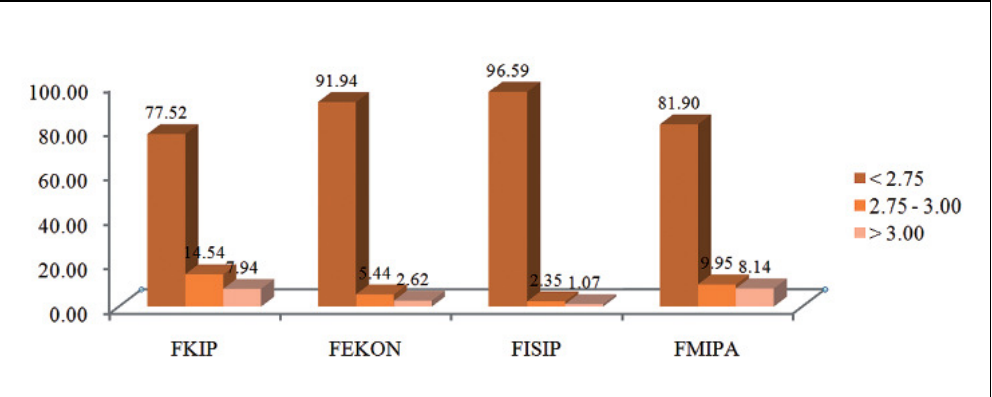
Figure 1 Distribution of GPA in four